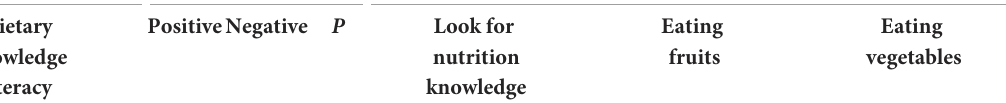
TABLE 1 Sample characteristics of the Chinese respondents with high-normal blood